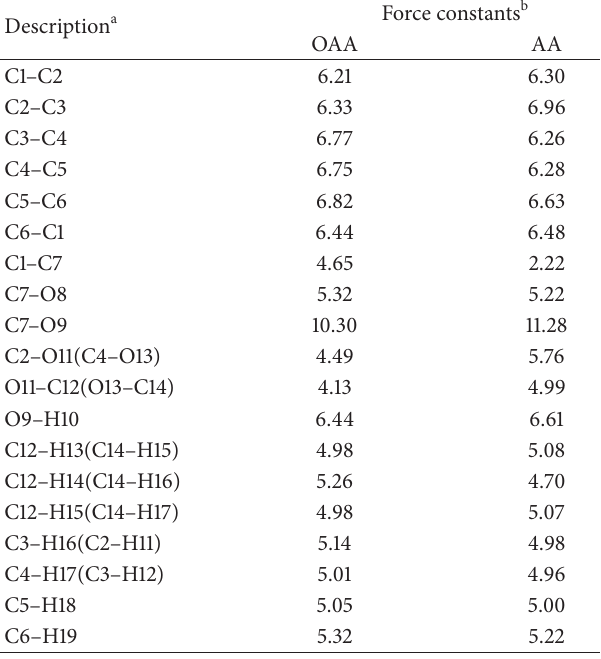
Table 6: Diagonal force constants (10 2 Nm − 1 ) of O-Anisic acid (OAA) and Anisic acid